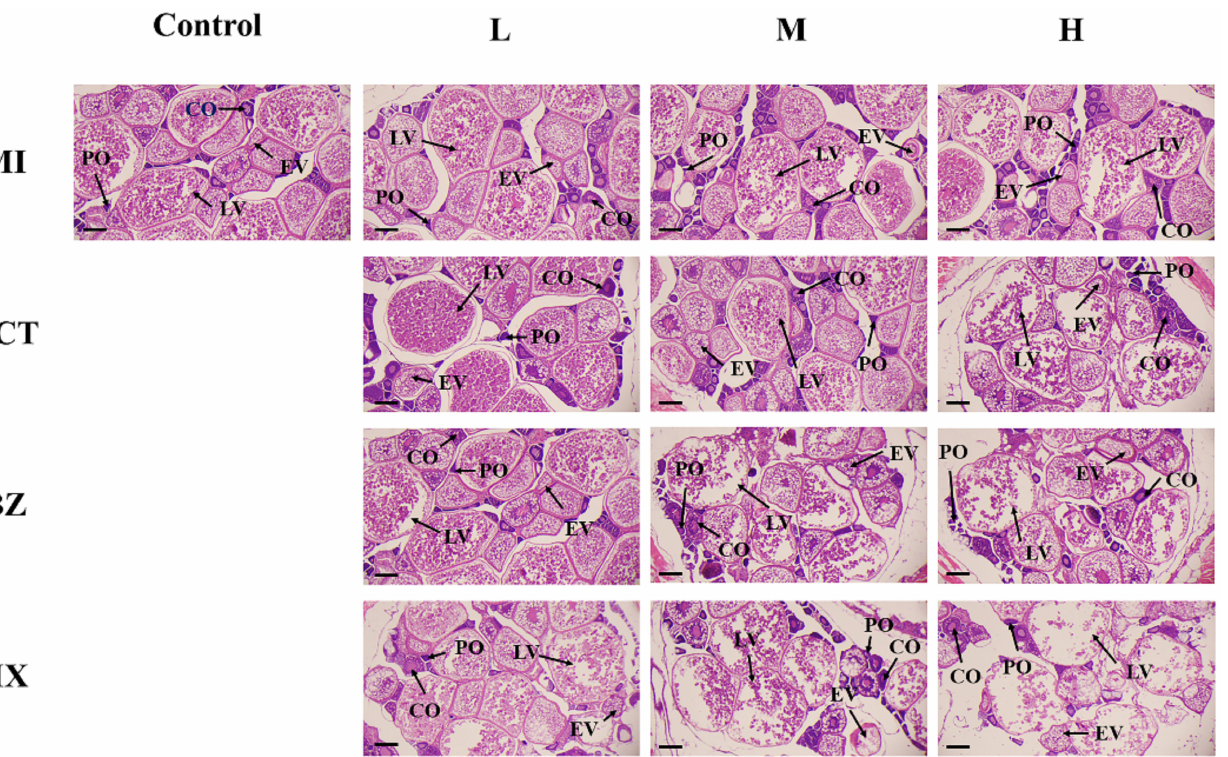
Figure 4. Histology microphotographs of the ovaries of F0 zebrafish after 28 d exposure. The oocytes in the ovaries included perinucleolar oocytes (PO), cortical alveolar oocytes (CO), early vitellogenic oocytes (EV) and late vitellogenic oocytes (LV) (50 magnification). Scale bar = 400 µ m. Here L: low concentration, M: medium concentration and H: high